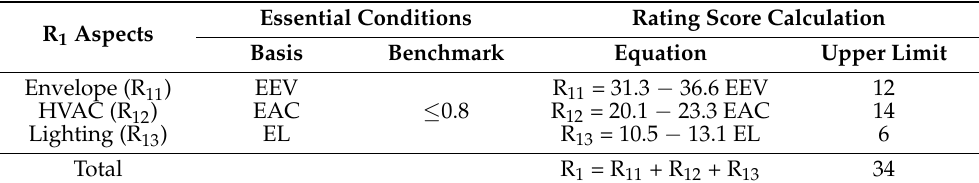
Table 3. Compilation of scores for energy savings of EEWH office